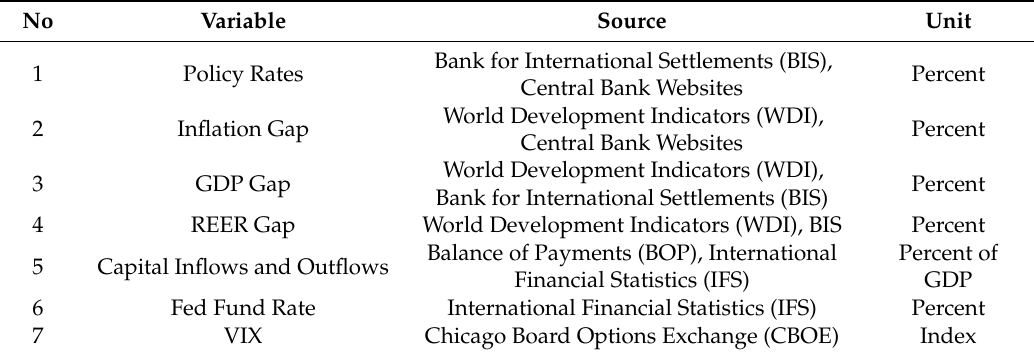
Table 1. List of Variables and Data